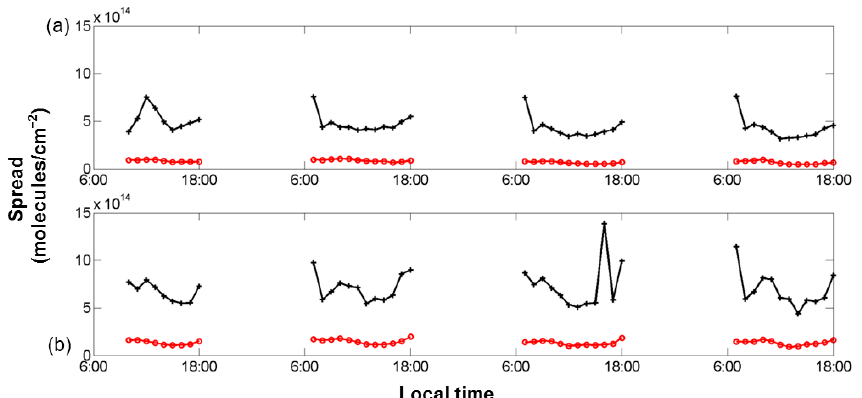
Figure 6. Time evolution of prior (black) and posterior (red) spreads of Denver TEMPO NO 2 column observation from 2 July 10:00 to 5 July 18:00 for REF (a) and ENS.1 (b)